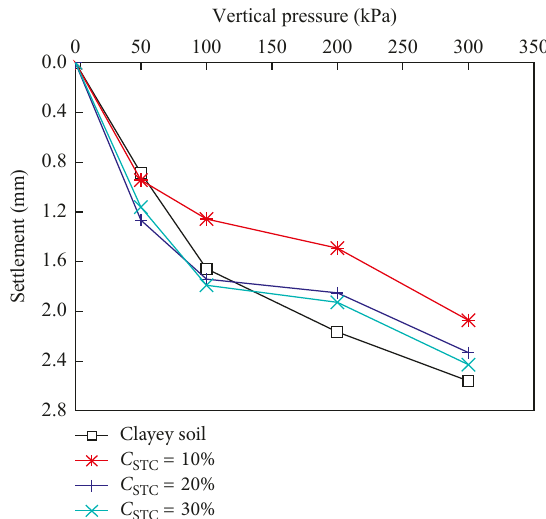
Figure 14: Settlement development with vertical pressure for mixtures.